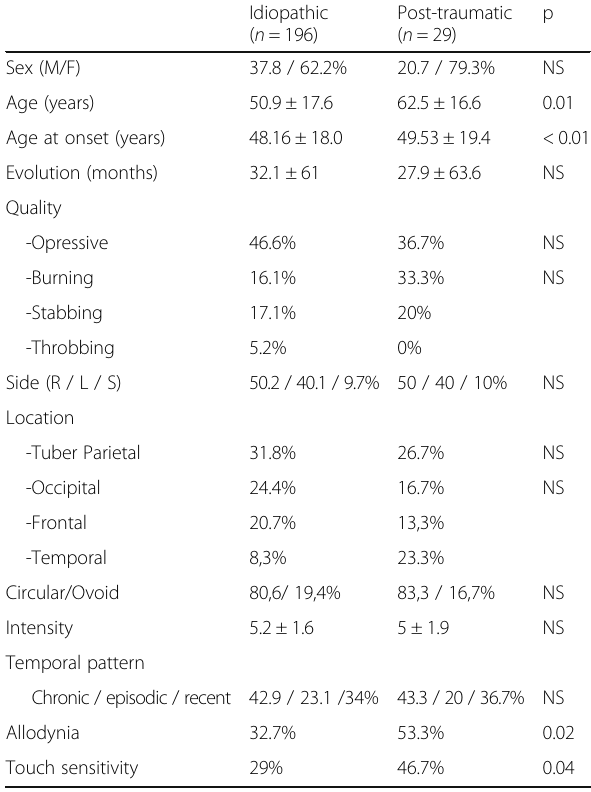
Table 2 Comparison between idiopathic NH and post-traumatic